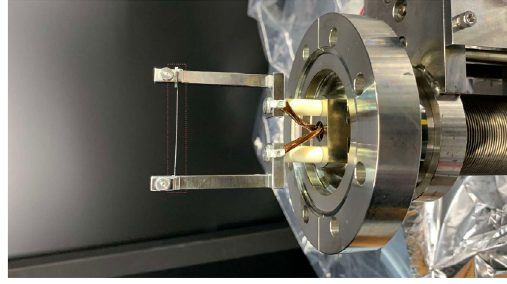
FIG. 2. Developed HOPG target installed in BSM. The red hatched box shows a target with dimensions 0 . 2 × 1 . 0 × 48 mm 3 .